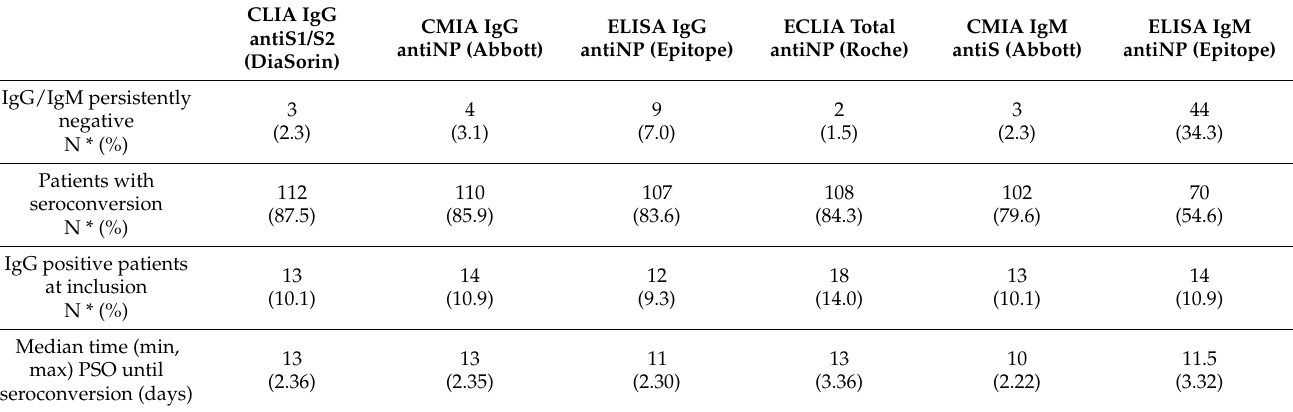
Table 3. Seroconversion rate in patients with serial serum